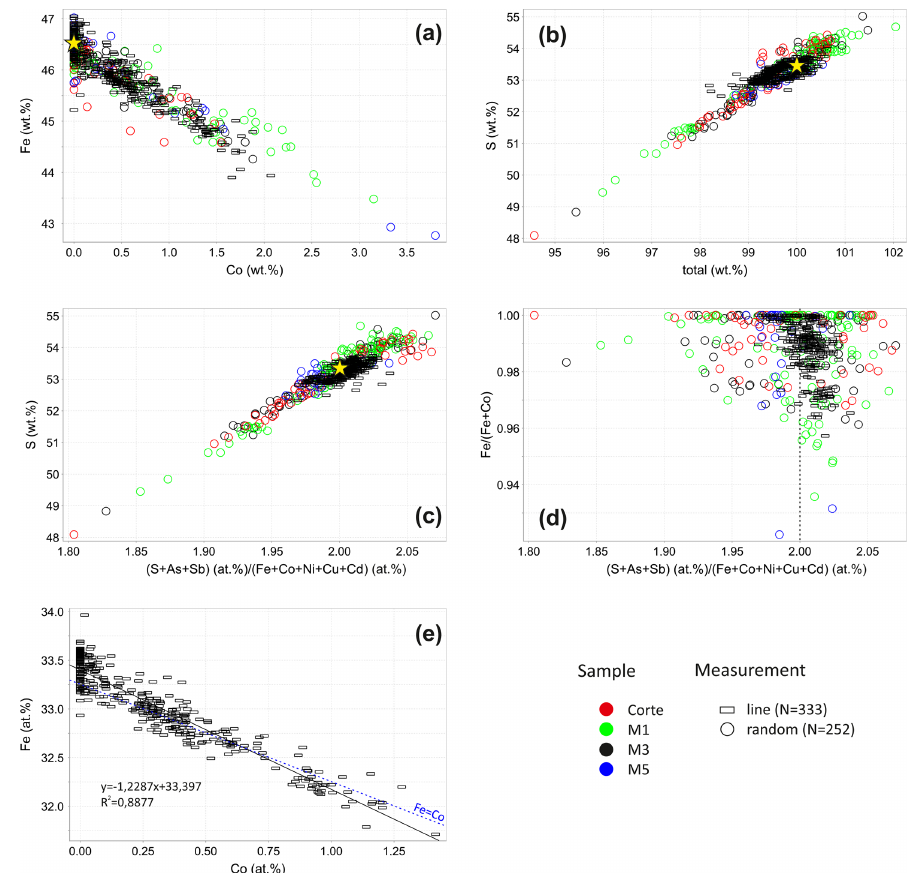
Figure 2. Correlation diagrams for relevant elements of analyzed pyrite grains. Yellow stars and dashed lines pose the theoretical composition of stoichiometric pyrite.